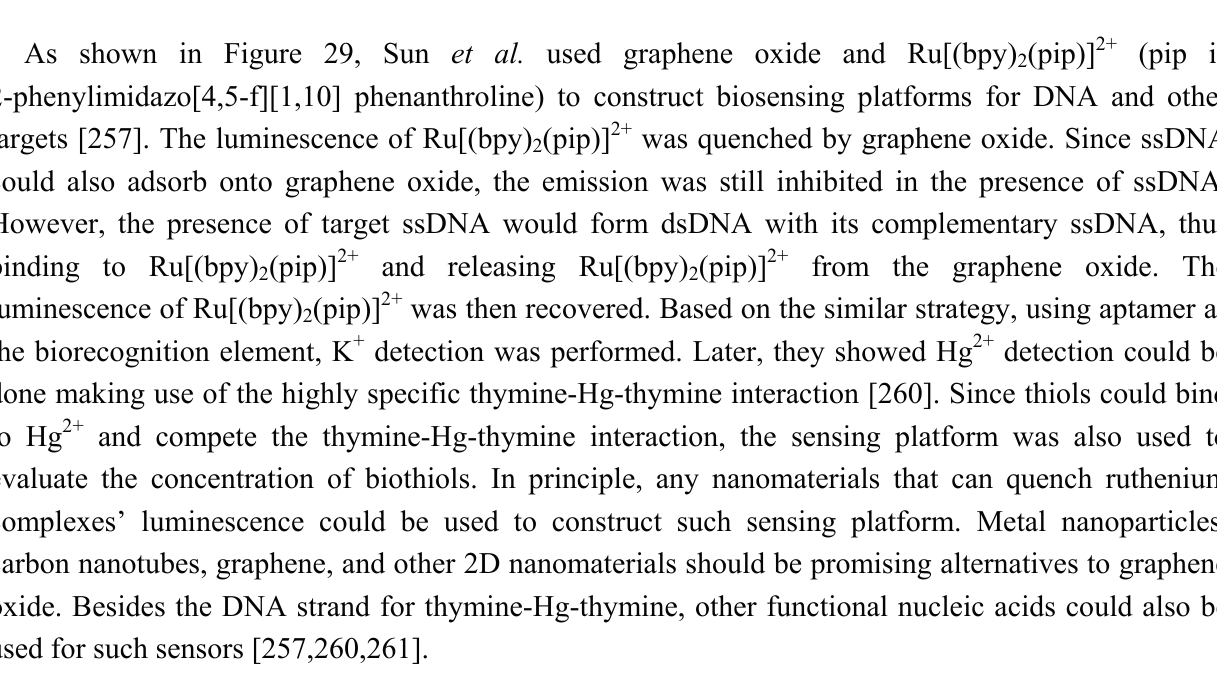
(pip)] 2+ and graphene oxide. Reprinted with 2